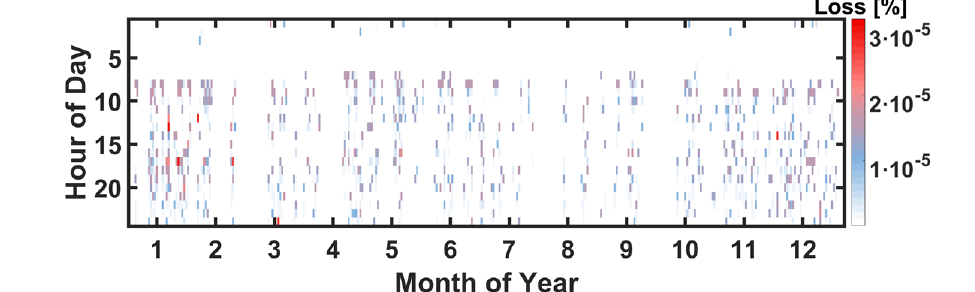
Figure 23. Hourly mean total loss increment for Scheme 1 (Conv-EG).